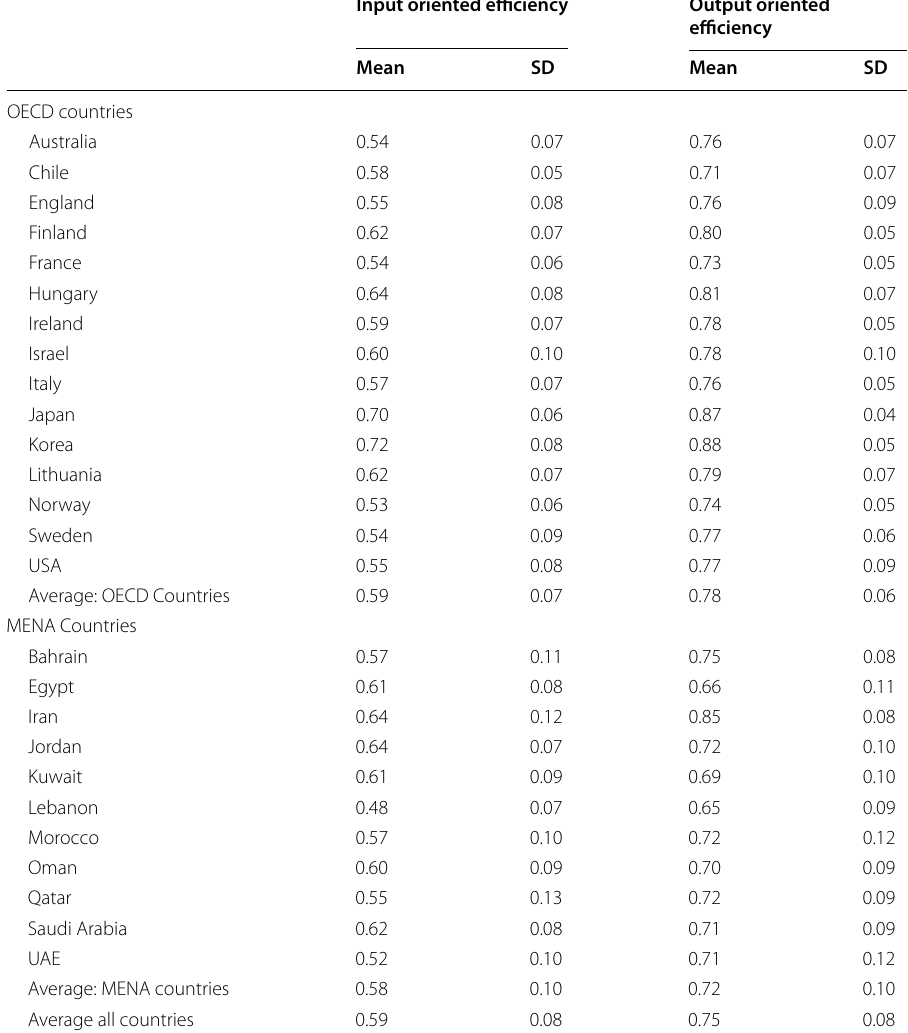
Table 5 Country-wise summary of school efficiencies Input oriented efficiency Output oriented